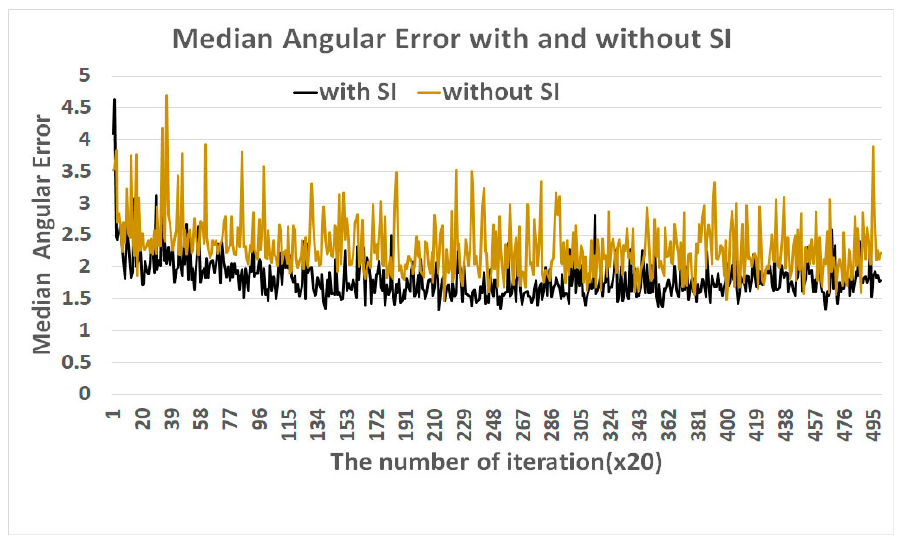
Figure 4. Comparison of median angular errors with and without semantic information (SI).